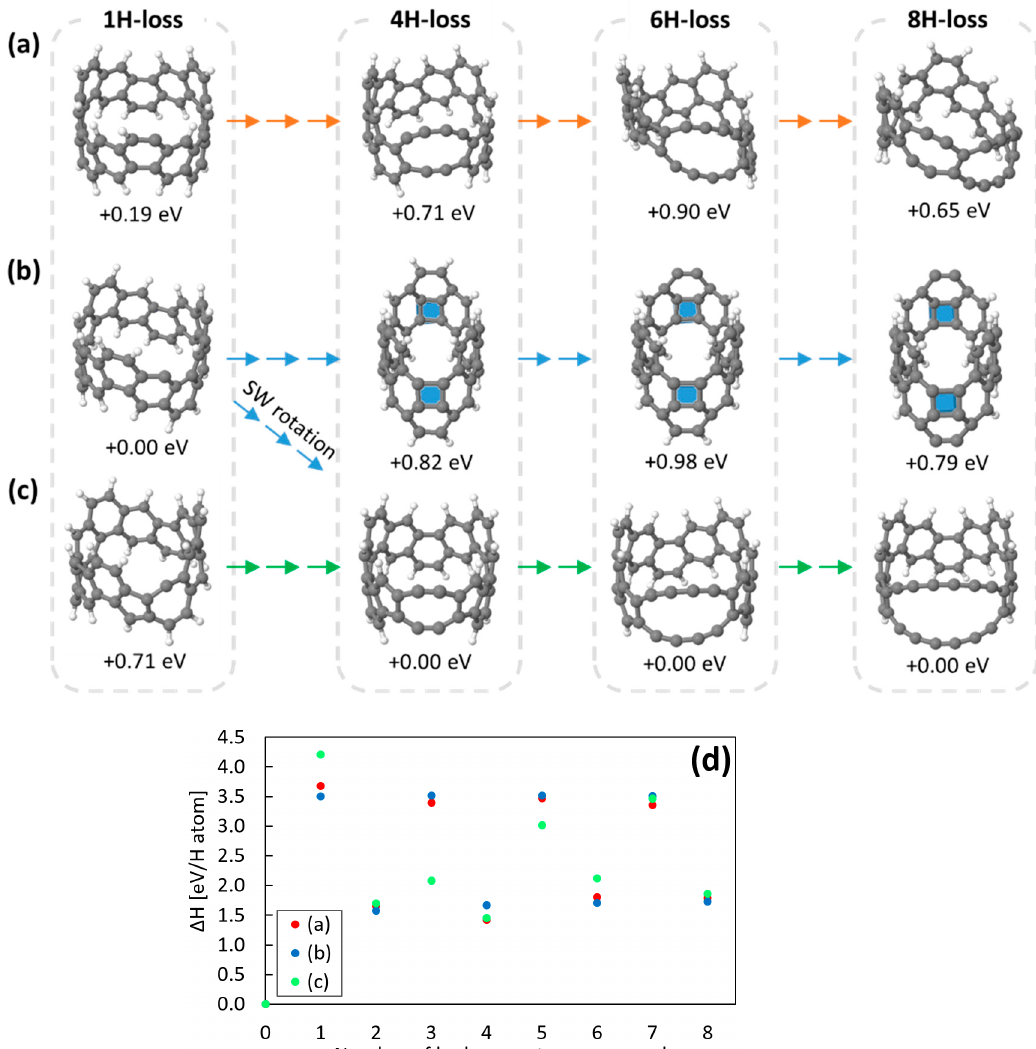
Figure 4. Carbon nanobelt maps ( a – c ) show key steps in the sequence of structures formed after sequential dehydrogenation. Route ( a ) begins with removal of exterior hydrogen atoms, route ( b ) with interior hydrogen atoms, and route ( c ) interior hydrogen atoms coupled to C-C bond rotations, as described in the text. The 1H-loss structures for ( a – c ) are shown in more detail in Figure 2. Grey and white spheres represent carbon and hydrogen atom, respectively. Each single arrow represents the removal of one hydrogen atom. Carbon squares are shaded in blue. The enthalpy value under each molecular model indicates the relative stability between the three isomers grouped vertically by grey dashed lines, i.e., between structures with the same number of hydrogen atoms (+0.00eV is the most stable structure each time). Importantly, the 4H-loss structure formed along the route ( c ) can also be formed from the 1H- and 2H-loss structures formed along ( b ) by the bond rotation. ( d ) shows the calculated enthalpy for removal of a single hydrogen atom from the previous structure for the three routes ( a – c ). A complete map showing every step is included in Supplementary Materials Figure